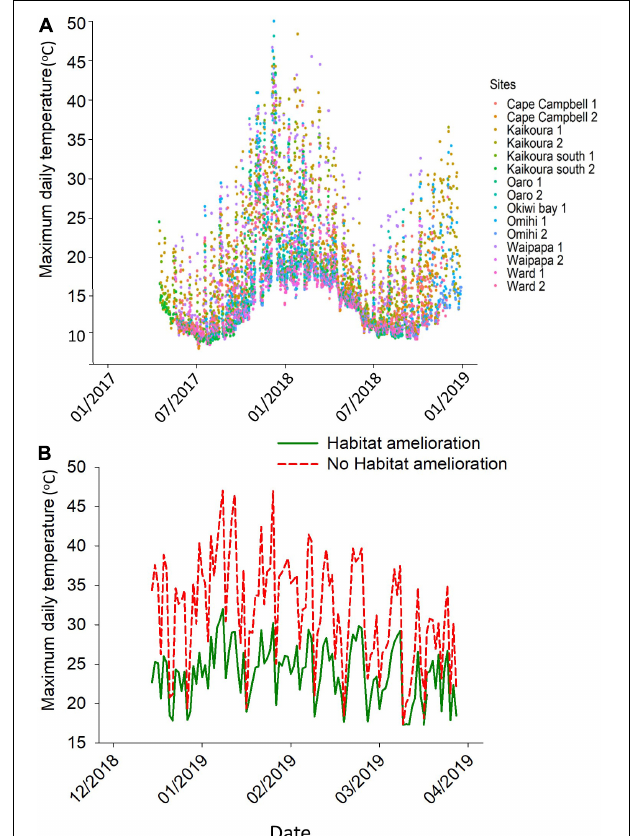
FIGURE 3 | (A) Color-fade graph of low shore temperatures across all sites from January 2017 to 2019. Note the numerous periods for most sites when temperatures exceed 40 ◦ C during the summer of 2018. (B) Effects of canopy facilitation of understory temperatures, above and below experimental canopy of Hormosira banksii on a lower mid tidal zone